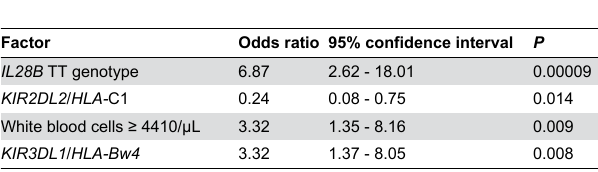
Table 3. Logistic regression analysis of variables contributing to a sustained virological response to pegylated interferon and